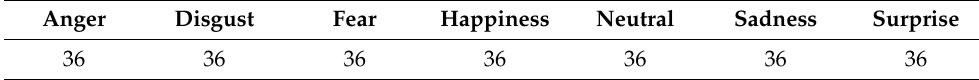
Table 2. Numbers of emotion samples used in the training phase.